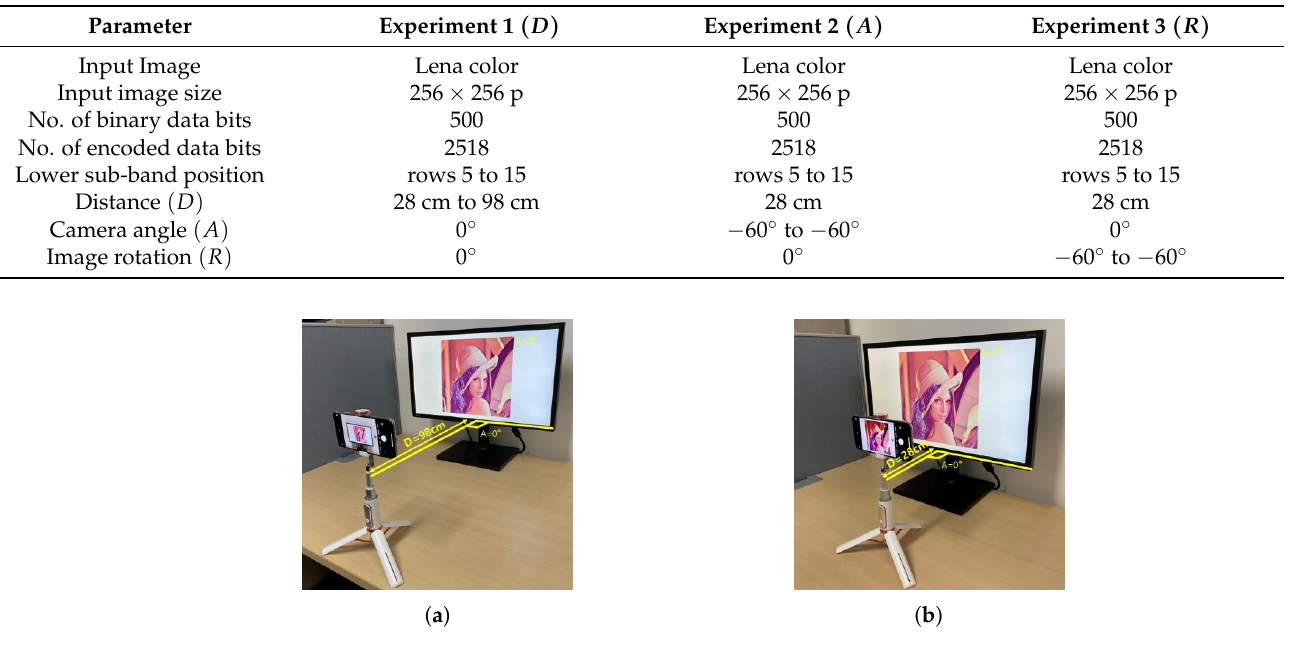
Table 6. Experimental parameters for distance, angle, and rotation evaluation.